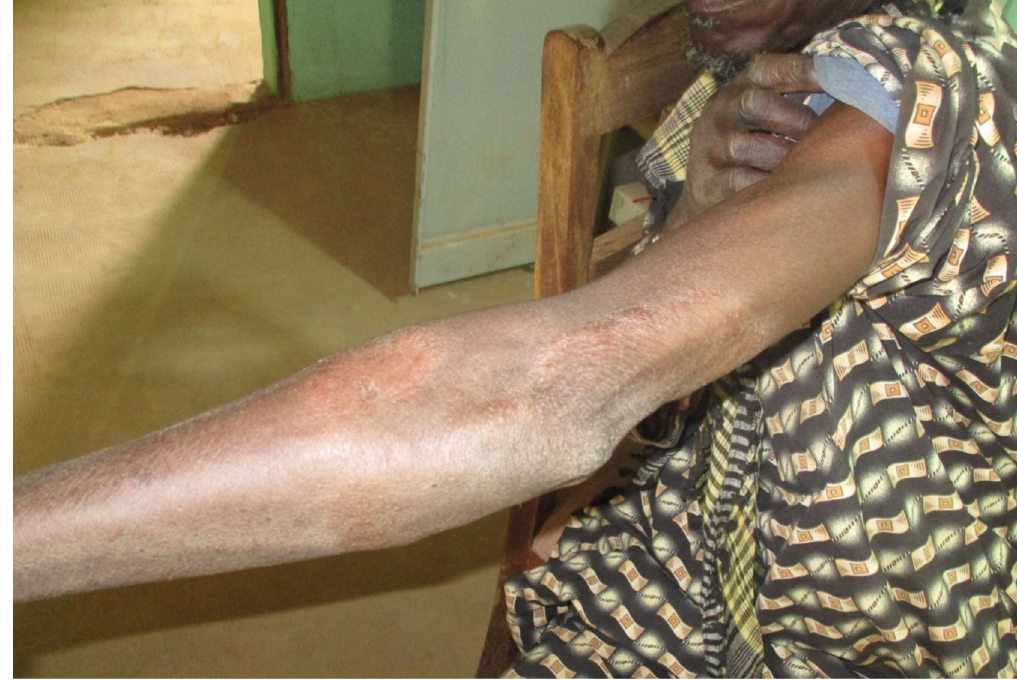
Figure 3. Paucibacillary leprosy: note the large hypochromic patch of the arm.